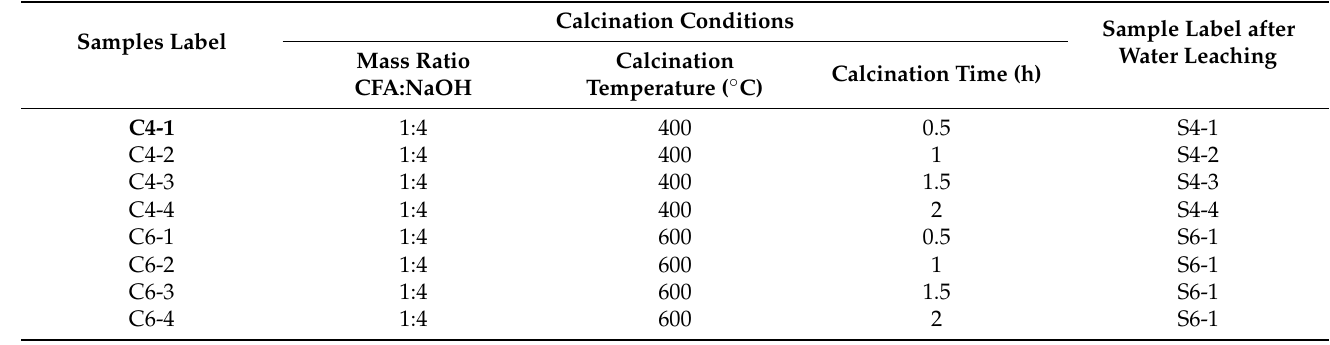
Table 2. Modification condition of